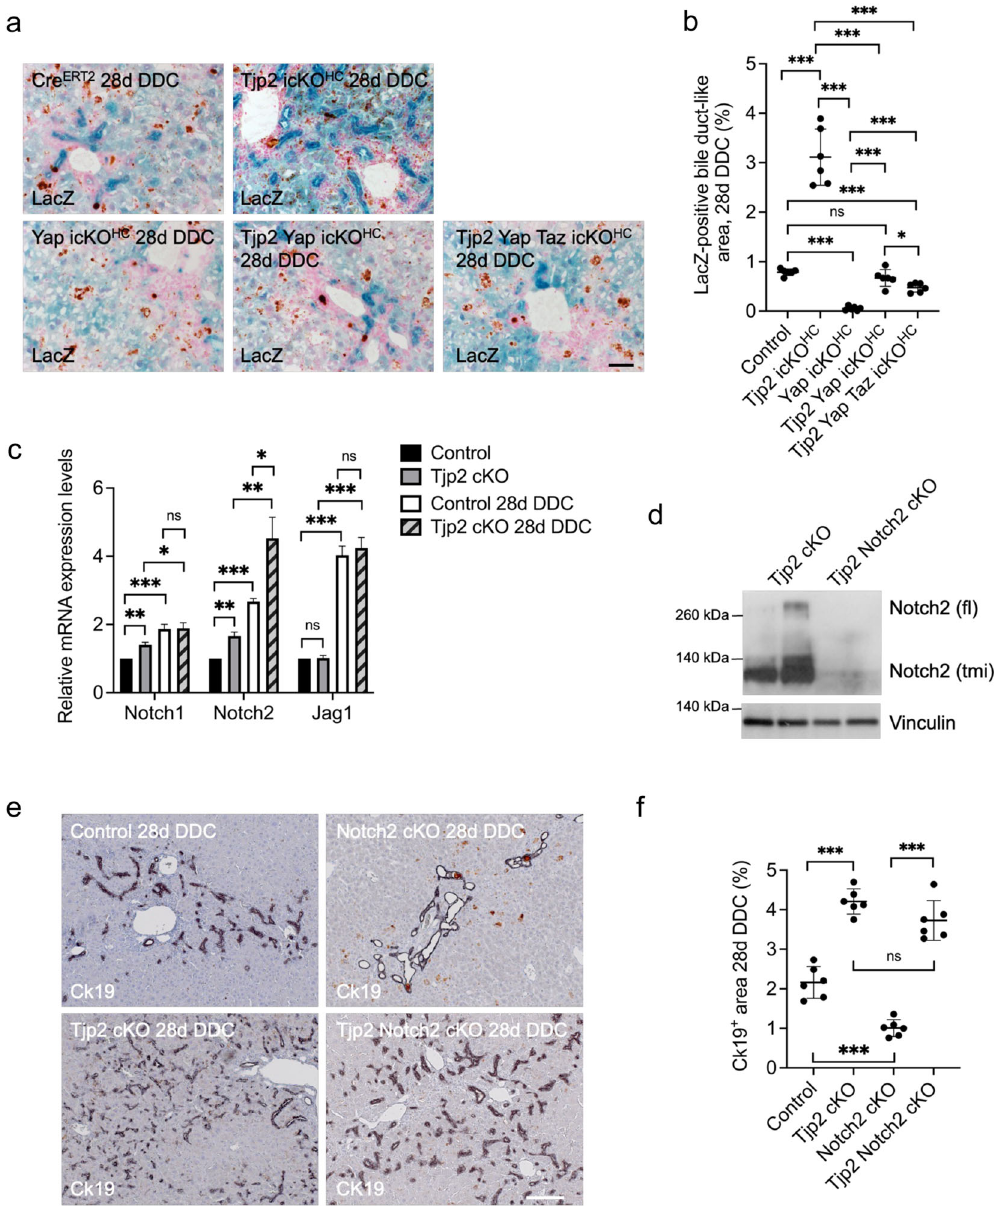
Fig. 7 Inactivation of Yap / Taz but not Notch2 prevents the DDC-diet-induced hepatocyte to cholangiocyte transdifferentiation in Tjp2 icKO HC or Tjp2 cKO mice. a , b LacZ staining of liver sections from the indicated mouse strains and quanti fi cation of LacZ-positive bile ducts. Scale bar: 100 μ m. c Liver mRNA expression levels of Notch1, Notch2, and Jag1 of Tjp2 cKO mice fed a normal or DDC diet and normalized to that of controls . d Western blot analysis of Notch2 to con fi rm deletion in the Tjp2 Notch2 cKO liver. (tmi: transmembrane and intracellular domain, fl L full-length). e , f Immunohistochemistry staining for Ck19 in liver sections from the indicated mouse lines and quanti fi cation. Scale bar: 100 μ m. Data in ( b , c , f ) are shown as mean ± SD, unpaired Student ’ s t test. * p < 0.05; ** p < 0.005, *** p < 0.0005, ns — not signi fi cant ( p > 0.05), with p < 0.05 considered a signi fi cant difference. ( b , f ): n = 6, ( c ): n = 3 mice per cohort. icKO HH , tamoxifen-induced hepatocyte Cat #12395 Cell Signaling, 1:50 dilution) and compatible fl uorescently labeled secondary antibodies (Invitrogen, 1:200 dilution).